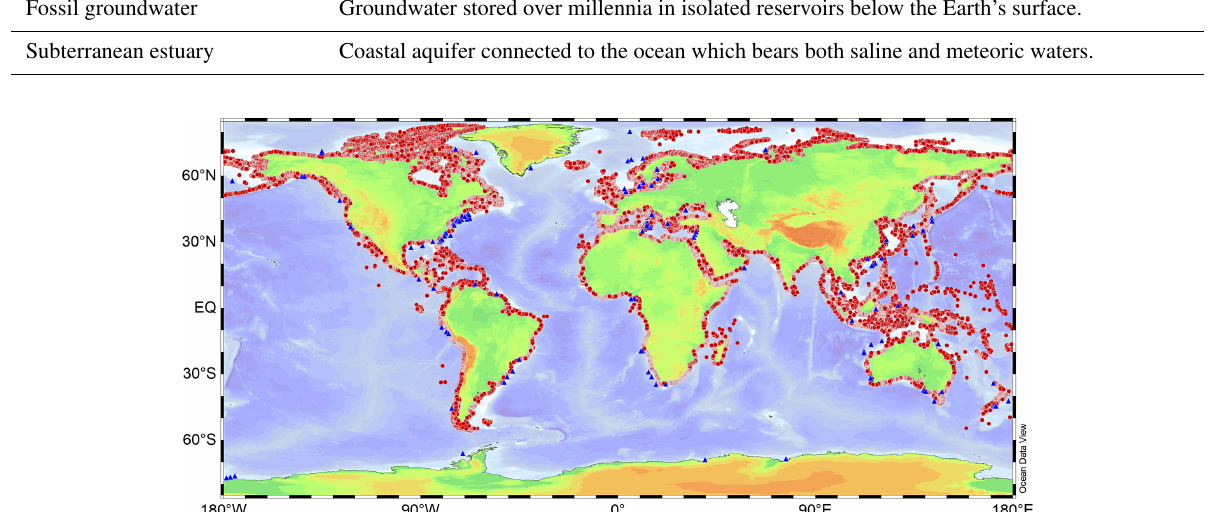
Figure 2. Global distribution of reported FSGD (red circles) and OFG (blue triangles) sites. Location data of FSGD and OFG from Luijendijk et al. (2020) and Micallef (2020),